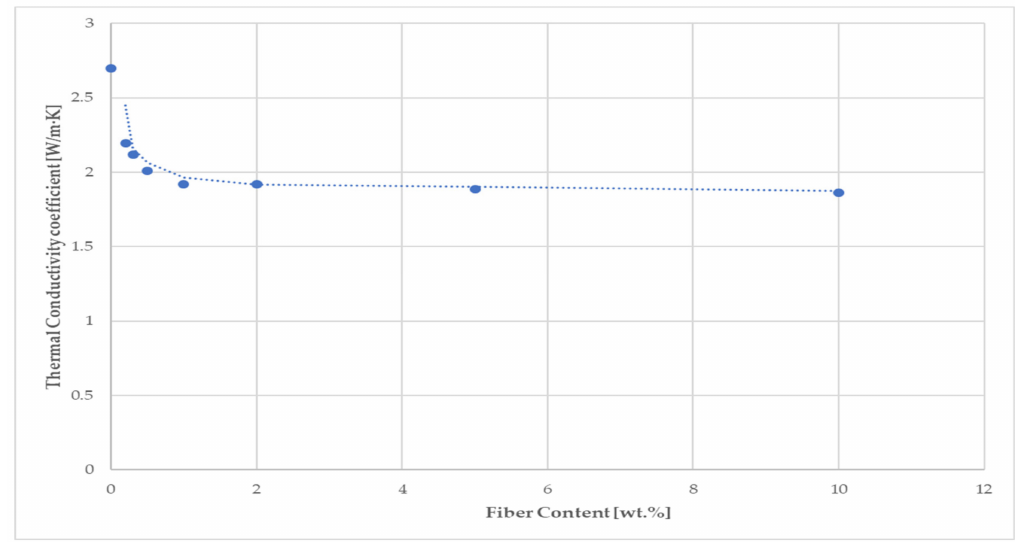
Figure 11. Dependence of the thermal conductivity coefficient of 28-day hardened fiber-cement mortars on the increased content of fiber sample C.